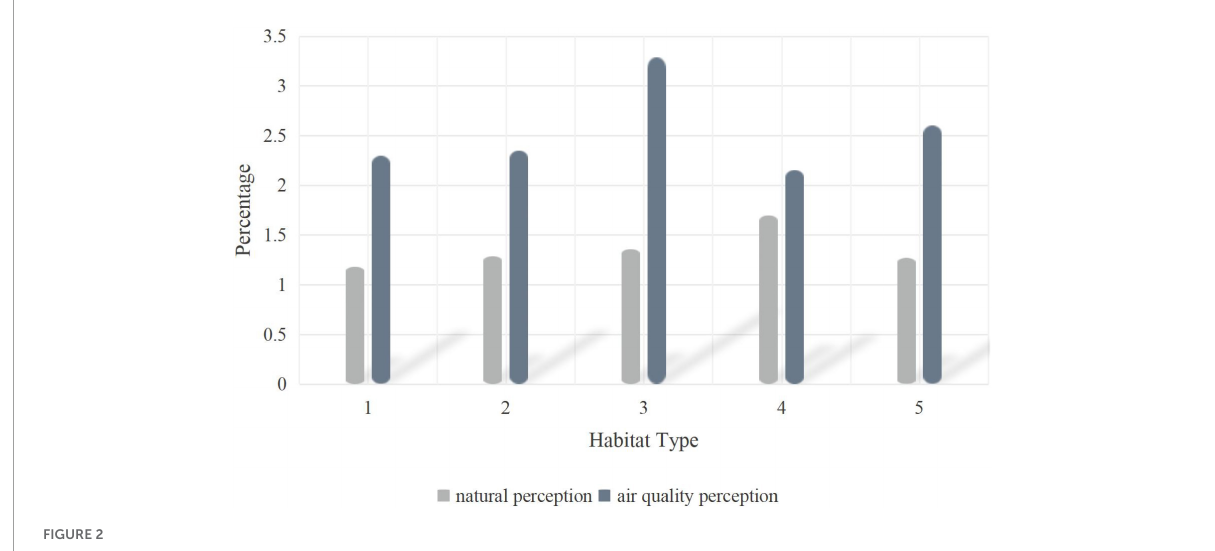
FIGURE2 Analysis of differences in natural perception and air quality perception of different habitat types.